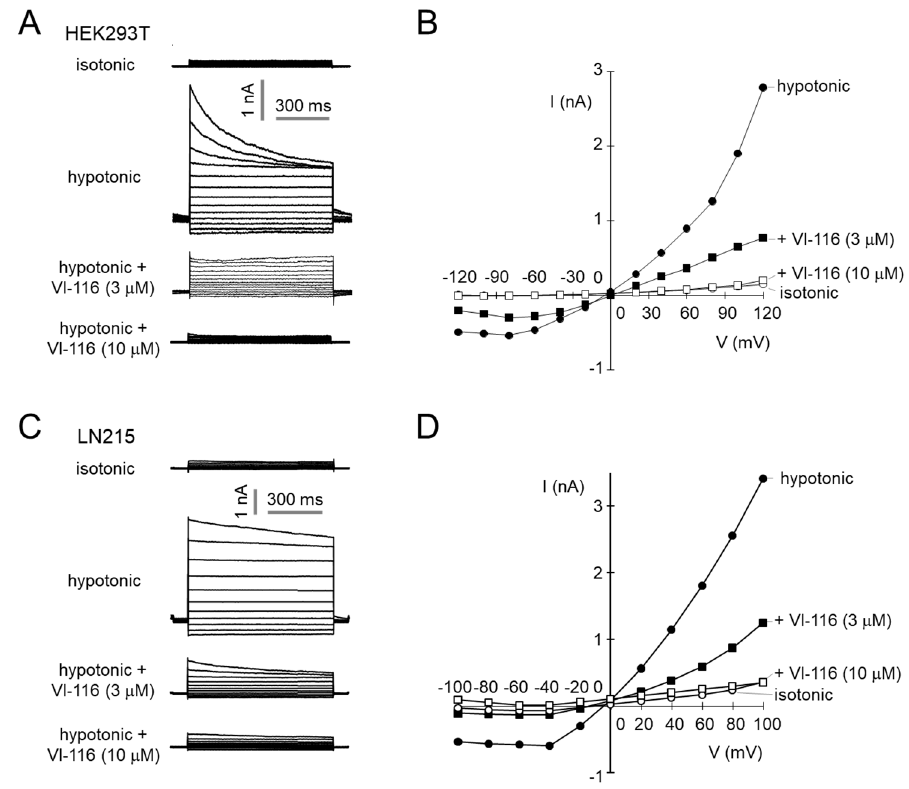
Figure 4. VI-116 potently blocks VRAC − mediated chloride current in HEK293T and LN215 cells. ( A ) Whole-cell membrane currents were recorded at a holding potential of − 50 mV by voltage steps ranging from − 120 to 120 mV (in steps of 20 mV) in HEK293T cells. VRAC was activated by application of hypertonic solution for 3 min, and then the cells were treated with indicated concentrations of VI-116. ( B ) Current/voltage plot of mean currents at the middle of each voltage pulse ( n = 3). ( C ) Whole-cell VRAC currents were recorded at a holding potential of − 50 mV by voltage steps ranging from − 100 to 100 mV (in steps of 20 mV) in LN215 cells. ( D ) Current/voltage plot of mean currents at the middle of each voltage pulse ( n =